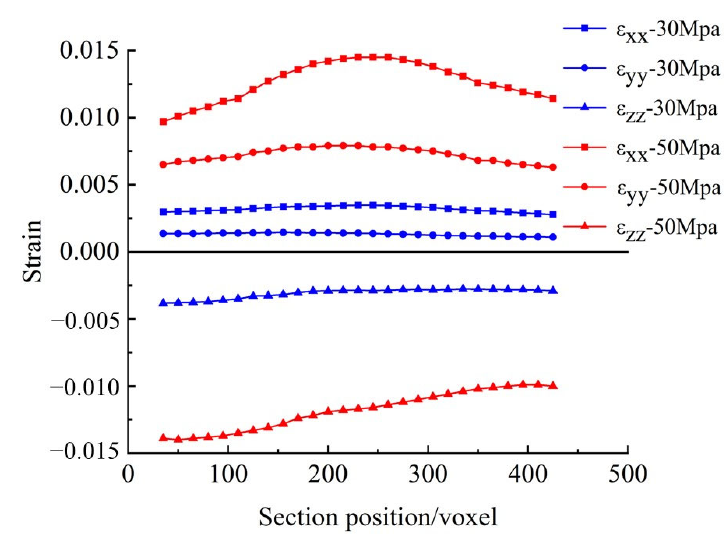
Figure 11. Strain distribution of di ff erent section